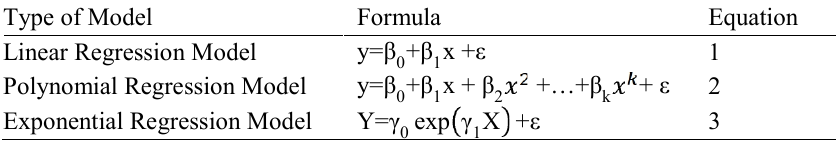
Table 1. Equations of linear and nonlinear curve fitting models